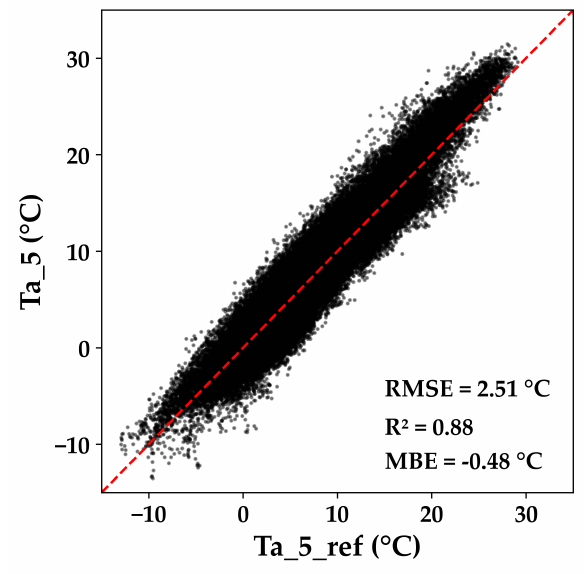
Figure 5. Comparison of ERA5-Land’s original Ta_5 and reference Ta_5_ref air temperatures.